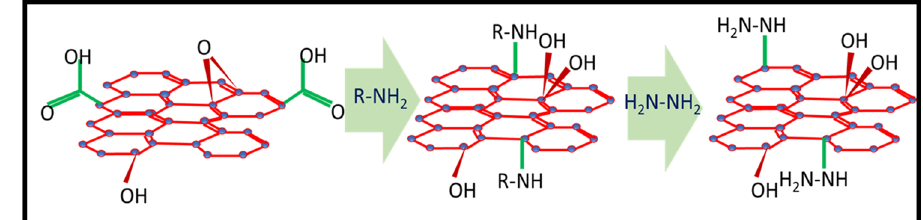
Figure 27: Scheme of amine bonding in HA – GO and HA – graphene papers.